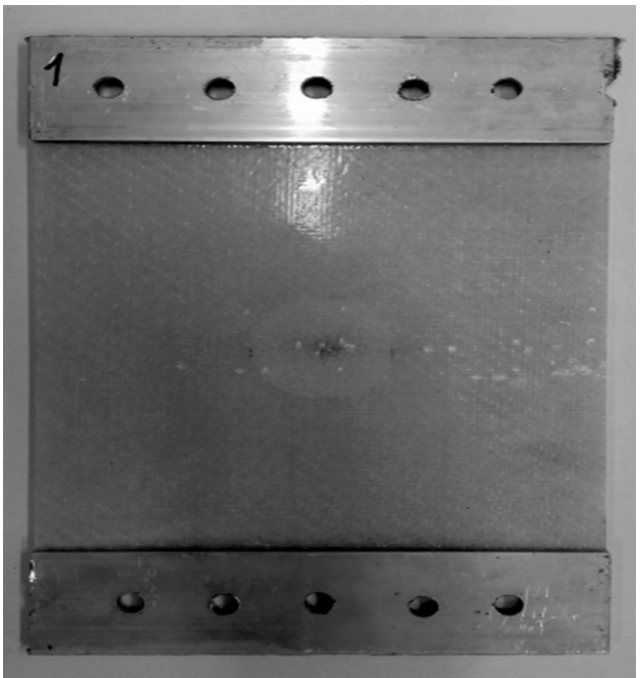
Figure 2. A square compressed plate with the embedded circular closed delamination a/L h/L x = 0.012—Ref. [11] (not to 0.3, h/L = 0.012—Ref. [11] (not to scale). x